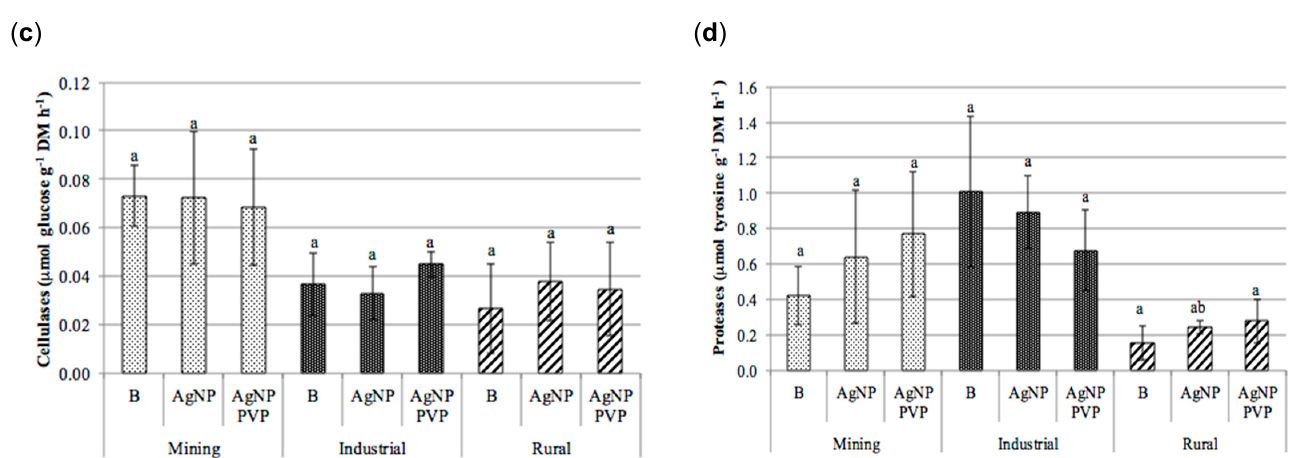
Figure 5. Enzymatic activities obtained in the soils (mining, industrial and rural) subjected to the different treatments (B): blank; AgNPs: silver nanoparticles; and PVP-AgNPs: silver nanoparticles polyvinylpyrrolidone coated); ( a ) acid phosphatase ( µ mol PNP g − 1 h − 1 ), ( b ) β -glucosidase ( µ mol PNP g − 1 h − 1 ), ( c ) cellulases ( µ mol glucose g − 1 h − 1 ), and ( d ) protease ( µ mol tyrosine g − 1 h − 1 ) (mean ± standard deviation, n = 9). For each soil type, columns marked with the same letter are not significantly different (Tukey HSD test, p > 0.05). PNP: p-nitrophenol.